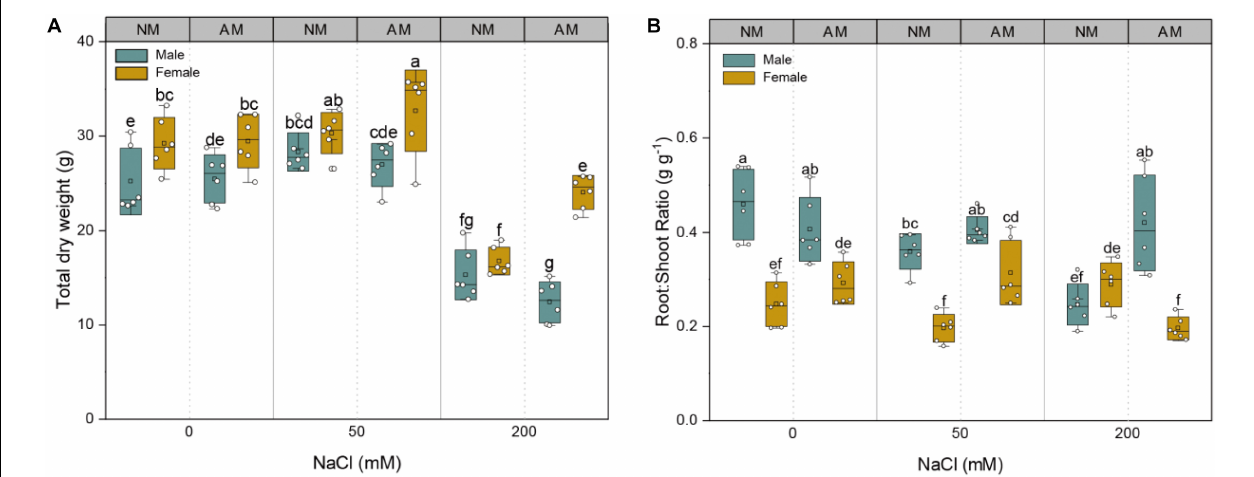
FIGURE 2 | Effects of arbuscular mycorrhizal fungus on total dry weight (A) and root/shoot ratio (B) in males and females of Morus alba under saline conditions. NM and AM represent inoculation with no mycorrhizal fungi and with Funneliformis mosseae , respectively. Bars represent means ± SD ( n = 6). Three-way ANOVA is performed to compare the effects of sex, salt, and AM inoculation and their interactions in both males and females. Different letters indicate a significant difference according to least significant difference at p < 0.05.